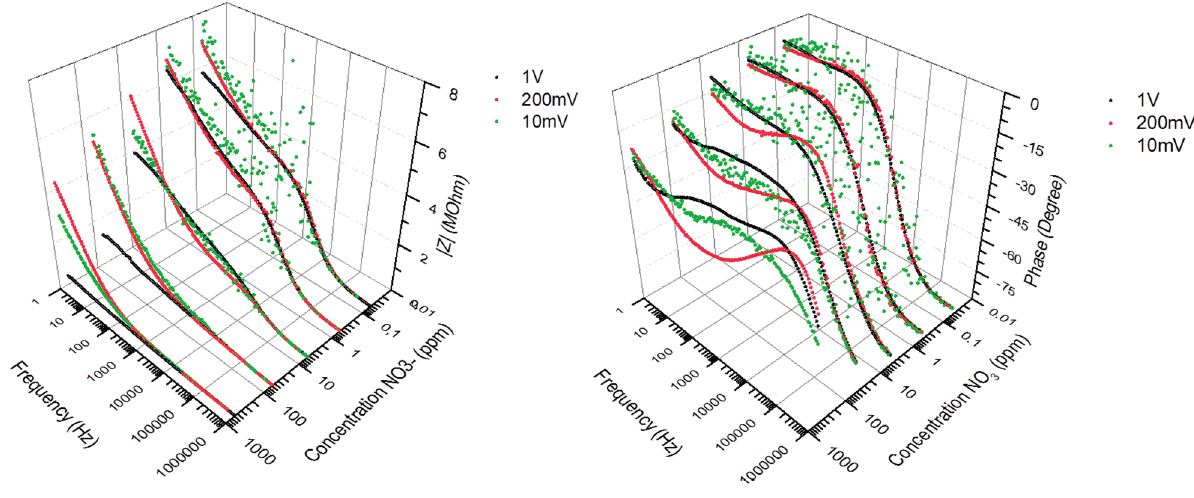
Figure 3. Impedance spectra (Modulus and Phase) of the PVC-BEHP electro-chemical nitrate sensors, at 10 mV (green dots), 200 mV (red dots), and 1 V (black dots) AC amplitudes, showing the measurement dependency with respect to the applied AC